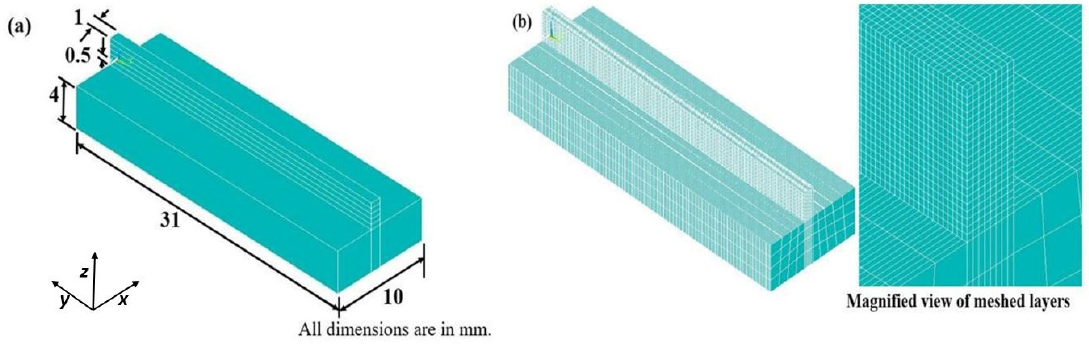
Figure 1. ( a ) Geometry of the FE model and ( b ) FE model of a five-layer selective laser melting (SLM) for Ti and Inconel 718 alloy material.